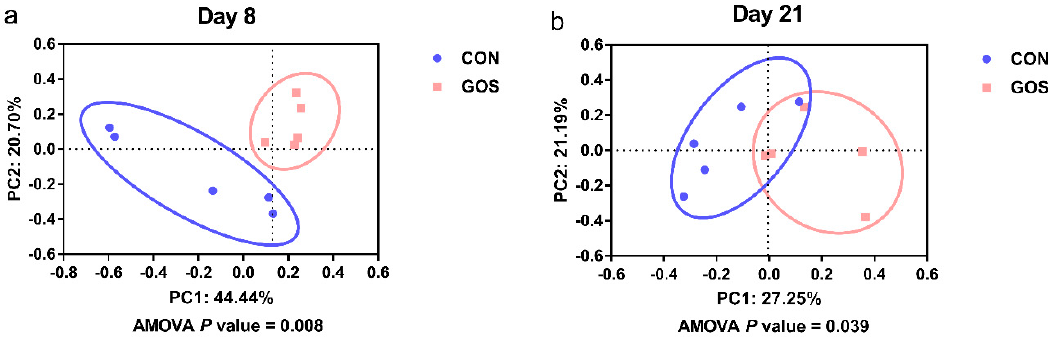
Figure 2. Principle coordinate analysis of ileum samples in the CON and GOS group. ( a ) The principle coordinate analysis of ileal microbiota on day 8; ( b ) the principle coordinate analysis of ileal microbiota on day 21. The percentage of variation explained by PC1 and PC2 are indicated in the axis. CON, a control group; GOS, a galacto-oligosaccharides intervention group.